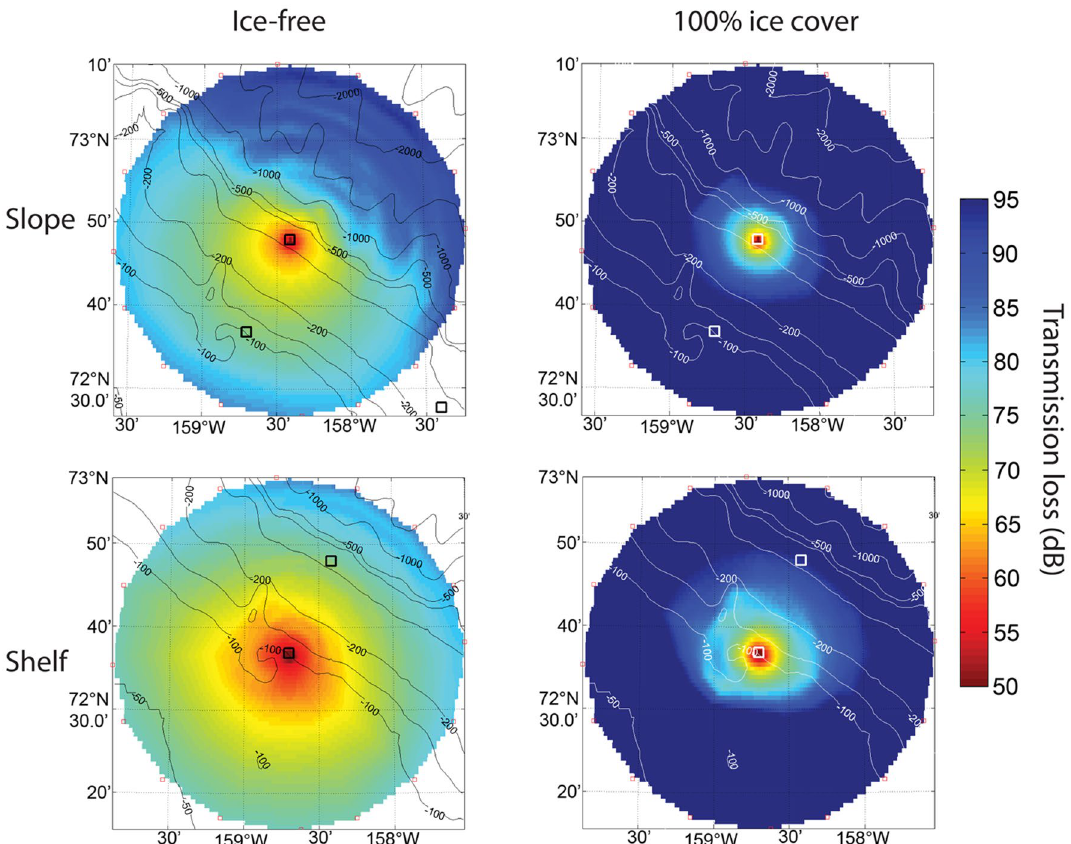
Figure 4. Transmission loss in dB for: open-water (left panels) and ice-covered (right panels) conditions for Chukchi slope (upper panels) and shelf (lower panels) sites with receivers at 320 and 88 m, respectively. Contour lines in